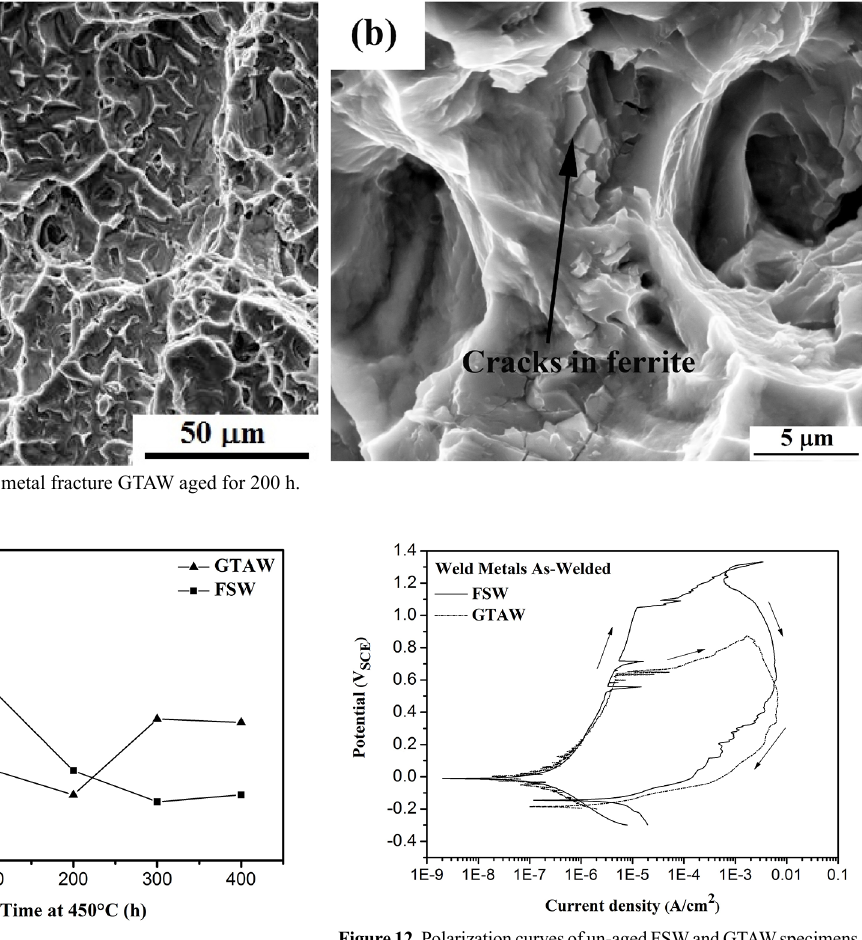
Figure 11. Pitting potential curves obtained by cyclic potentiodynamic tests.